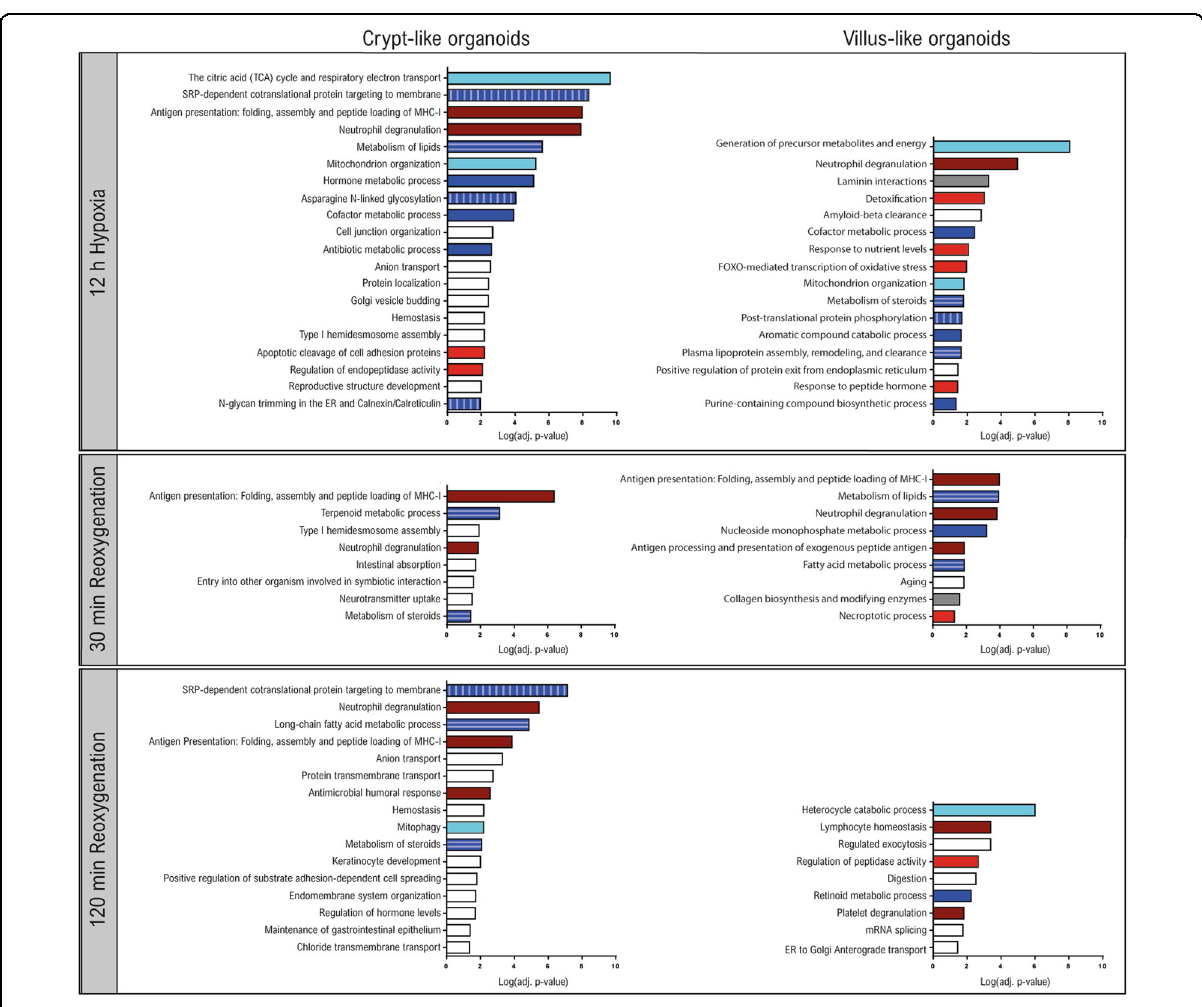
Fig. 3 Functional enrichment analysis. Enriched biological processes at 12H, 30R, and 120R compared to Ctrl in CL organoids (left) and VL organoids (right) are shown. A combined list of signi fi cantly up- and downregulated proteins was used for analysis, and an adjusted p -value < 0.05 was considered statistically signi fi cant. Enrichment analysis for GO biological processes and Reactome pathways was performed using METASCAPE. Bar colors indicate groups of selected processes. Processes related to mitochondrial structure and metabolism (light blue), enriched in both CL and VL organoids. Metabolic processes (dark blue): protein metabolism, enriched in CL organoids (vertical stripe); lipid metabolism, in CL and VL organoids (horizontal stripe). Processes related to stress response and apoptosis (red), more pronounced in VL organoids. Extracellular matrix interactions (gray), enriched in VL organoids. Immune response (dark red), enriched in both CL and VL